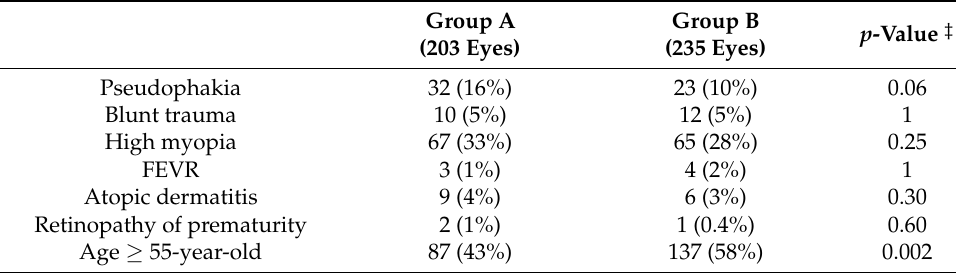
Table 2. Background factors.